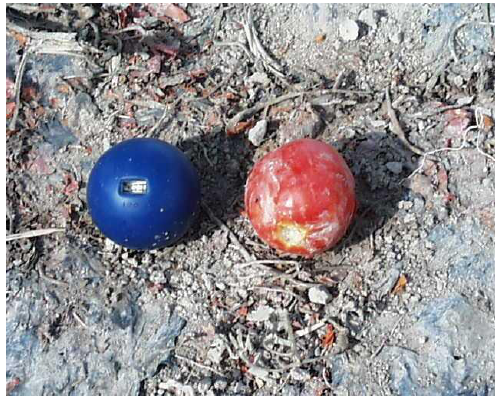
Figure 2. IRD sensor near a tomato